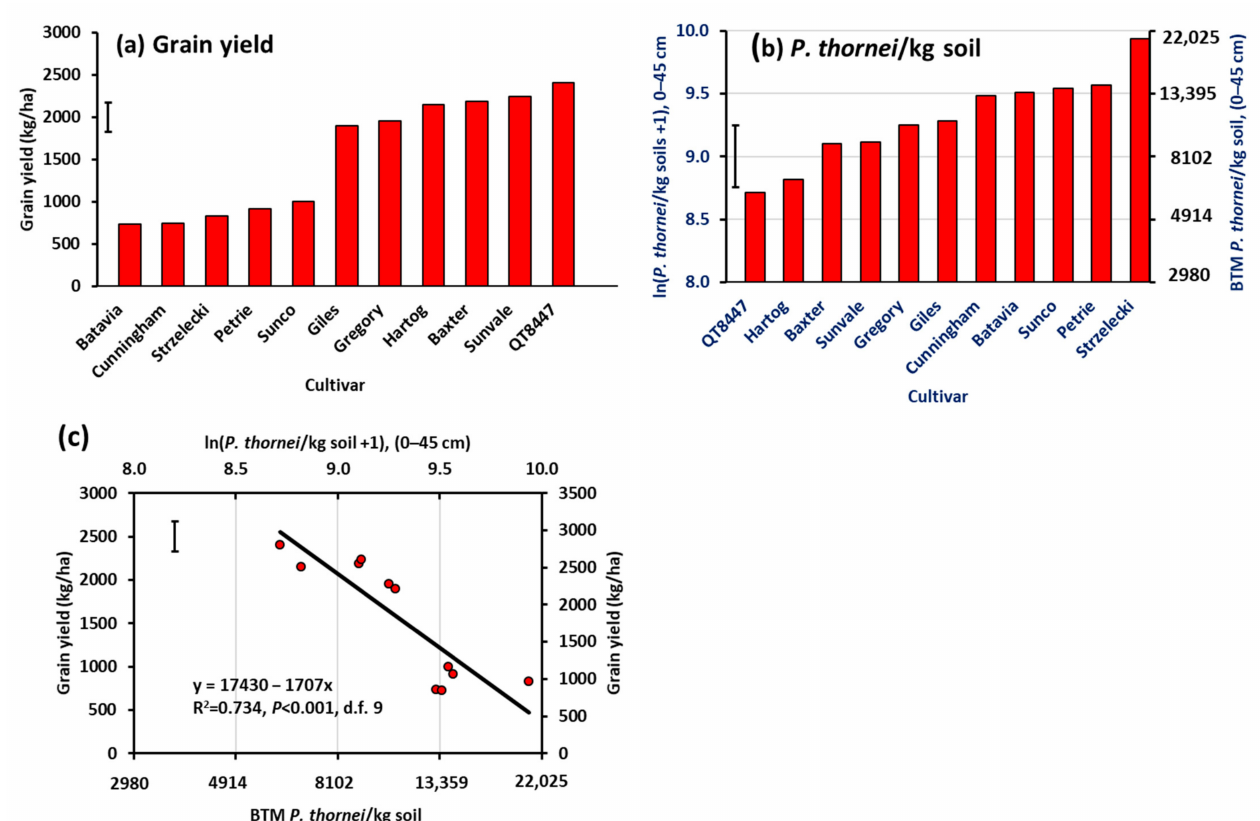
Figure 2. ( a ) Grain yield of 11 wheat cultivars in Experiment 1, ( b ) mean ln( P. thorneiI /kg soil +1) of final population densities in the soil profile to 45 cm depth after harvest, and ( c ) regression relationship between yield and P. thornei population density. Cultivars are in ascending order of value on the Y -axis in ( a , b ). BTM = back-transformed mean. Bar markers represent the l.s.d. ( p =